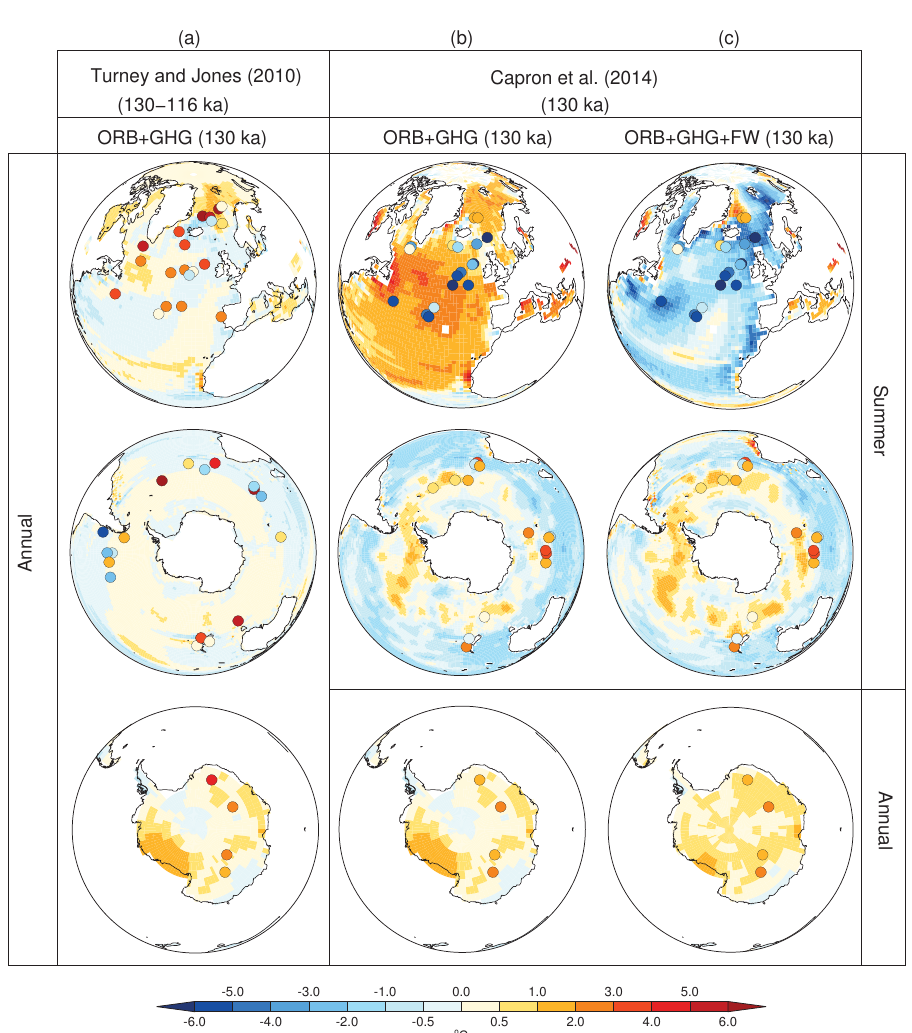
Figure 5. Simulated 130ka SSTs and near-surface air temperature anomalies compared with data for the high-latitude regions. The top two rows are SSTs (annual or summer as labelled) and the bottom row is annual mean near-surface air temperature. Left panel, (a) : LIG peak warmth data synthesis of Turney and Jones (2010) (dots) compared with 130ka annual temperature anomalies (GHG and orbital forcing only). Middle panel, (b) : the 130ka data-based time slice (dots) compared with simulated summer-SST anomalies for the NH (July, August, and September) and SH (January, February, and March) (GHG and orbital forcing only). Right panel, (c) : the 130ka data-based time slice (dots) compared with summer-SST anomalies for the NH and SH (GHG, orbital forcing, and a constant freshwater input of 0.2Sv into the North Atlantic). Note the non-linear temperature scale. Anomalies calculated relative to the modern period for both the model and the data.